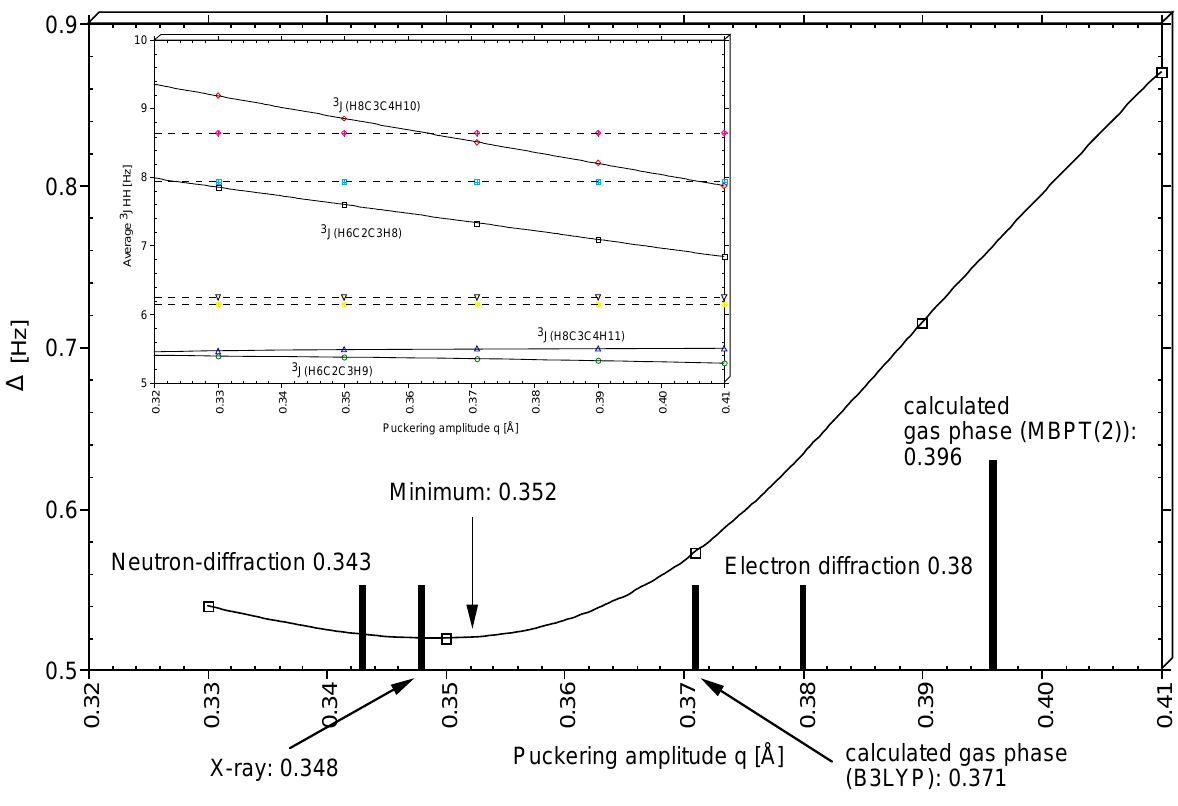
Figure 9: The total deviation ∆ of calculated from experimental SSCCs < 3 J(HCCH) > is given as a function of q. The minimum determines the best q value. It is compared with the q values from other sources. In the insert, the dependence of the calculated SSCCs < 3 J(HCCH) > of THF on the puckering amplitude q is given. Experimental values (dashed lines) are given for